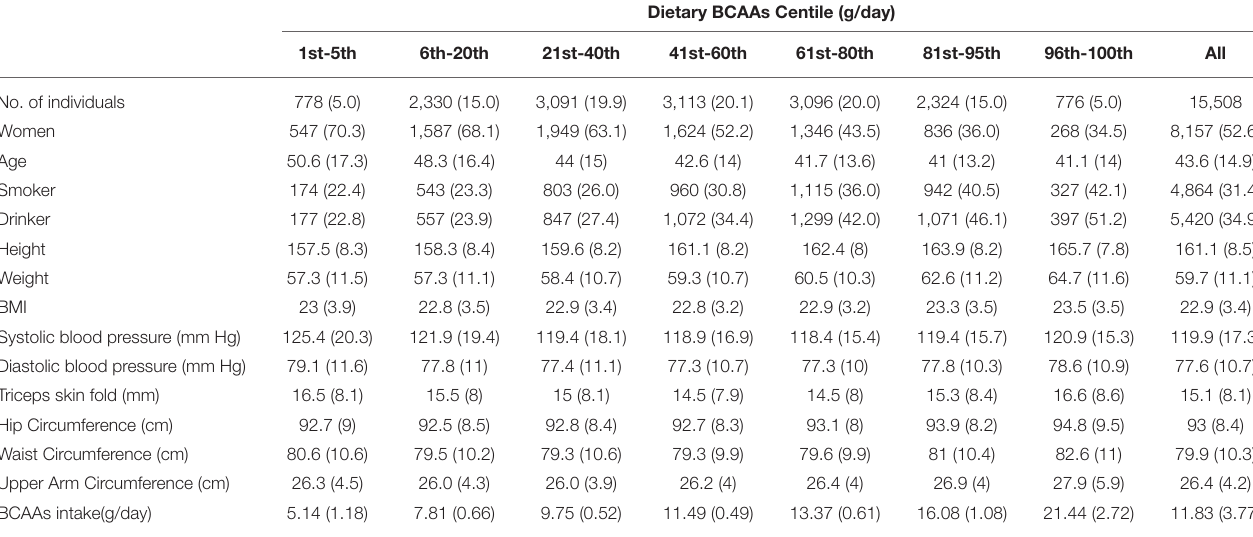
TABLE 3 | Baseline characteristics of 15,508 individuals in the CHNS